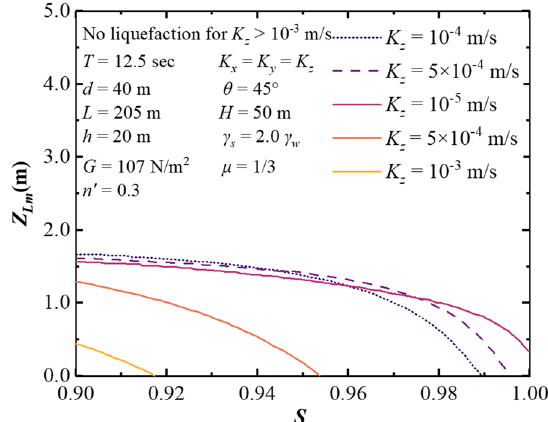
Fig. 11 Distribution of the maximum liquefaction depth Z Lm versus S r for various K z values (modified from Jeng